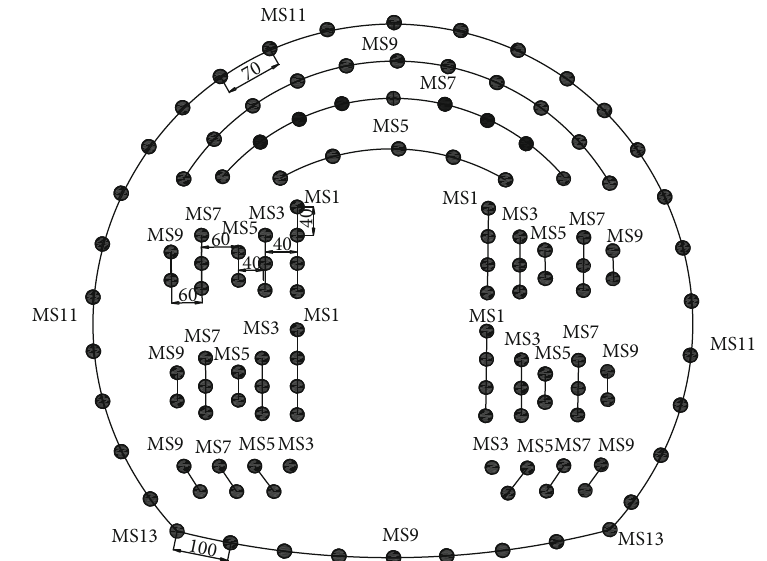
Figure 3: Layout of the blast hole.